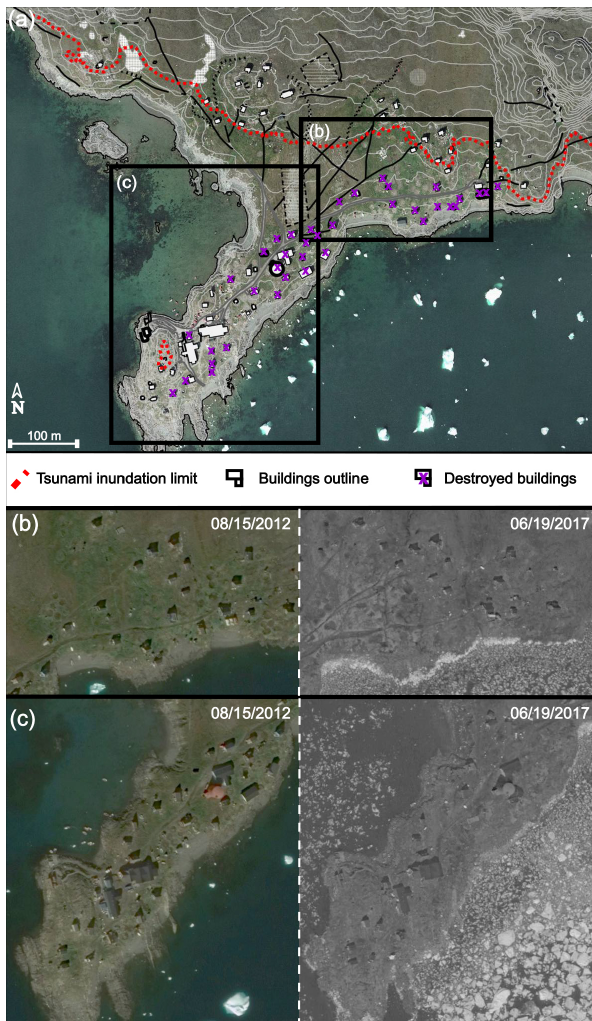
Figure 7. Scale of destruction in settlement infrastructure. (a) Gen- eral overview of area inundated by the tsunami with location of damaged buildings. The inventory of tsunami-induced changes of settlement infrastructure is based on interception of aerial images, local spatial plans, and field surveying. Background orthophoto and topographic map: nunagis.gl. (b) Satellite image of settlement be- fore the tsunami impact (15 August 2012) and (c) satellite image of settlement after the tsunami impact illustrate the scale of destruction and dislocation of buildings (19 June 2017). Background Google Earth Image © 2020 Maxar